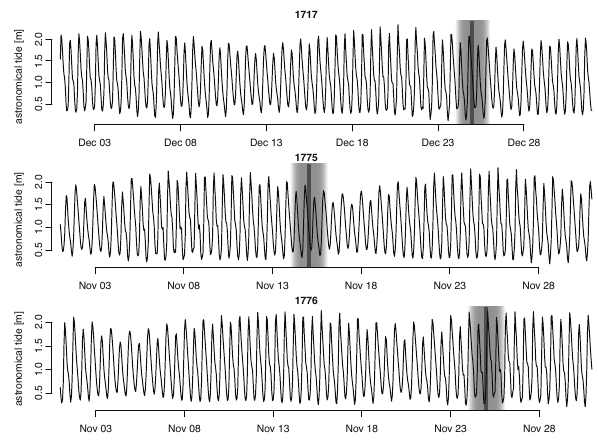
Fig. 5. Astronomical tide for the IJmuiden station during the storms of 1717, 1775 and 1776 (marked in